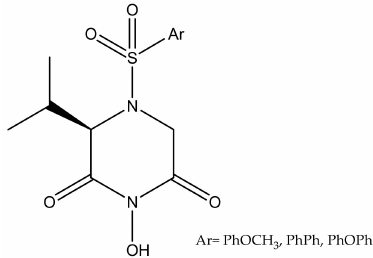
Figure 12. 1-hydroxypiperazine-2,6-dione (HPD) derivatives [52].